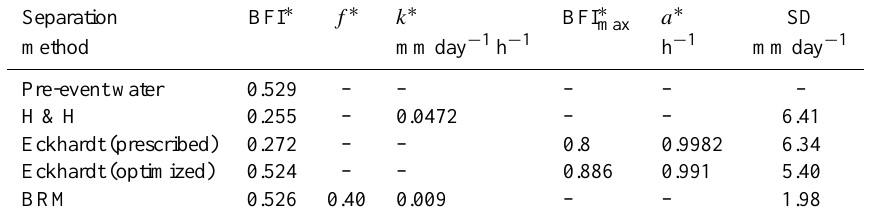
Table 1. Tracer calibration of the baseflow separation methods by comparison with pre-event water determined using deuterium for a streamflow event on 23 February 1988 at Glendhu GH1 Catchment (Bonell et al., 1990). The listed parameters were determined as described in the text. The standard deviations (SD) show the goodness of fit between the various baseflows and the pre-event water.